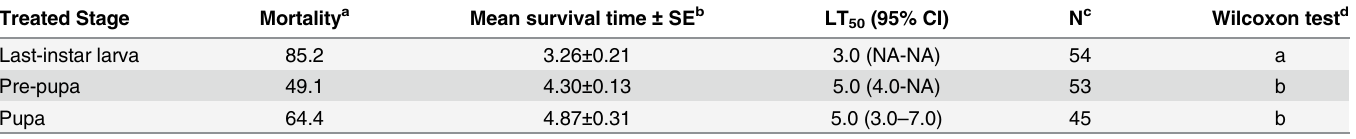
Table 3. Corrected mortality (%), mean survival time and LT 50 (days) of L . decemlineata immature stages inoculated with 500 IJs of S . feltiae . Treated